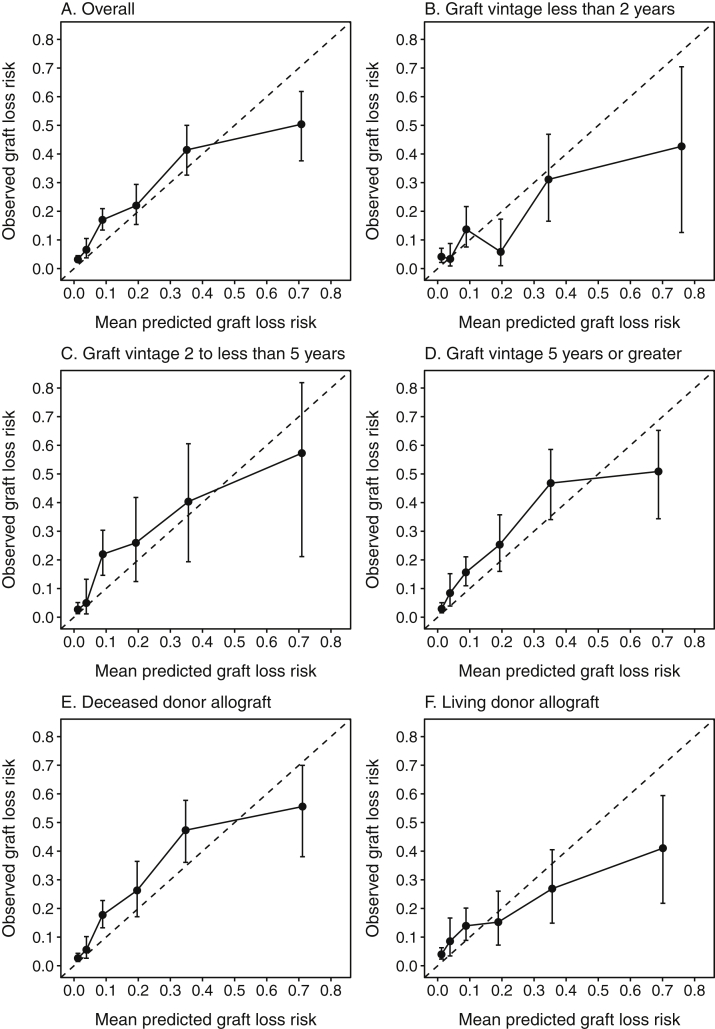
Observed versus predicted graft loss risk using 4-variable Kidney Failure Risk Equation at 5 years. The dotted line denotes perfect agreement between observed and predicted risk. Error bars represent 95% CIs for cumulative incidence of graft loss with return to dialysis within 5 years.